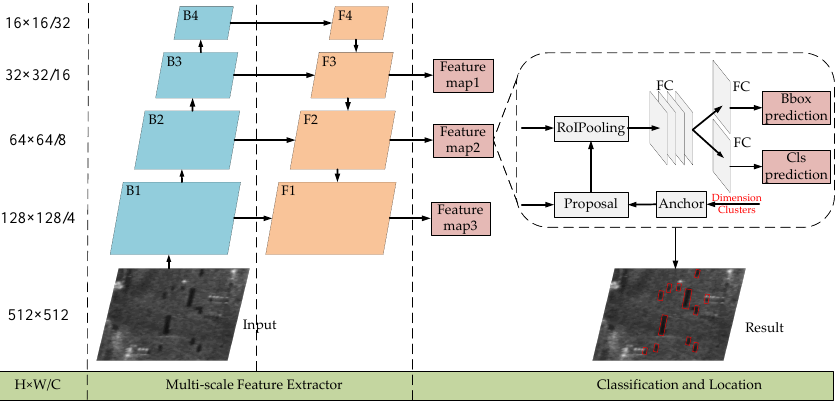
Figure 3. The detailed architecture of multi-scale